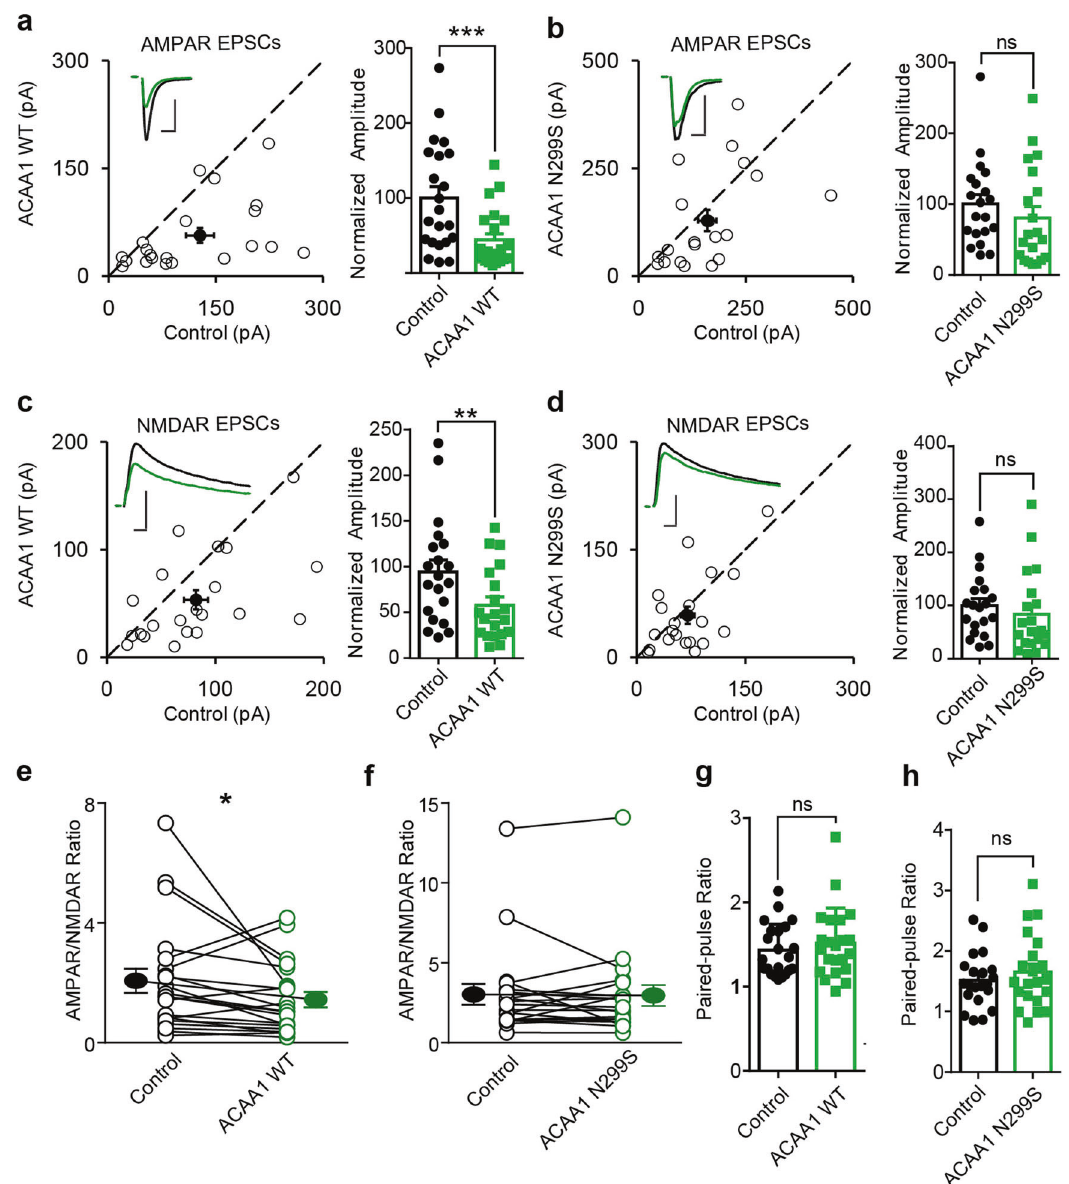
Fig. 7 ACAA1 p.N299S disturbs its physiological regulation of excitatory synaptic transmission. a – d Rat hippocampal slice cultures were biolistically transfected with expression vector of ACAA1 WT or ACAA1 p.N299S. Simultaneous dual whole-cell recordings were performed in a transfected CA1 pyramidal neuron (green trace) and a neighboring wild-type one (black trace). The evoked AMPA ( a , b ) and NMDA ( c , d ) EPSCs were measured, and open and fi lled circles represent amplitudes for single pairs and mean ± SEM, respectively. Sample current traces from control (black) and experimental (green) cells are shown as insets. Bar graphs show normalized EPSC amplitudes (mean ± SEM) of − 70 mV ( a , *** P < 0.001; b , P > 0.05) and + 40 mV ( c , ** P < 0.005; d , P > 0.05) presented in scatter plots. The scale bars for representative EPSC traces are 100 pA/25 ms ( a ) and 50 pA/25 ms ( b – d ). e , f Difference of AMPA/NMDA ratios recorded from neurons overexpressing ACAA1 WT (* P < 0.05) or ACAA1 p.N299S ( P > 0.05) compared to the respective wild-type (Control) ones. g , h No change in paired-pulse ratio of the second EPSC over the fi rst EPSC from neurons overexpressing ACAA1 WT ( P > 0.05) or ACAA1 p.N299S ( P > 0.05) relative to the control neurons. All the statistical differences are estimated relative to the respective control neurons, with a two-tailed Wilcoxon signed-rank sum